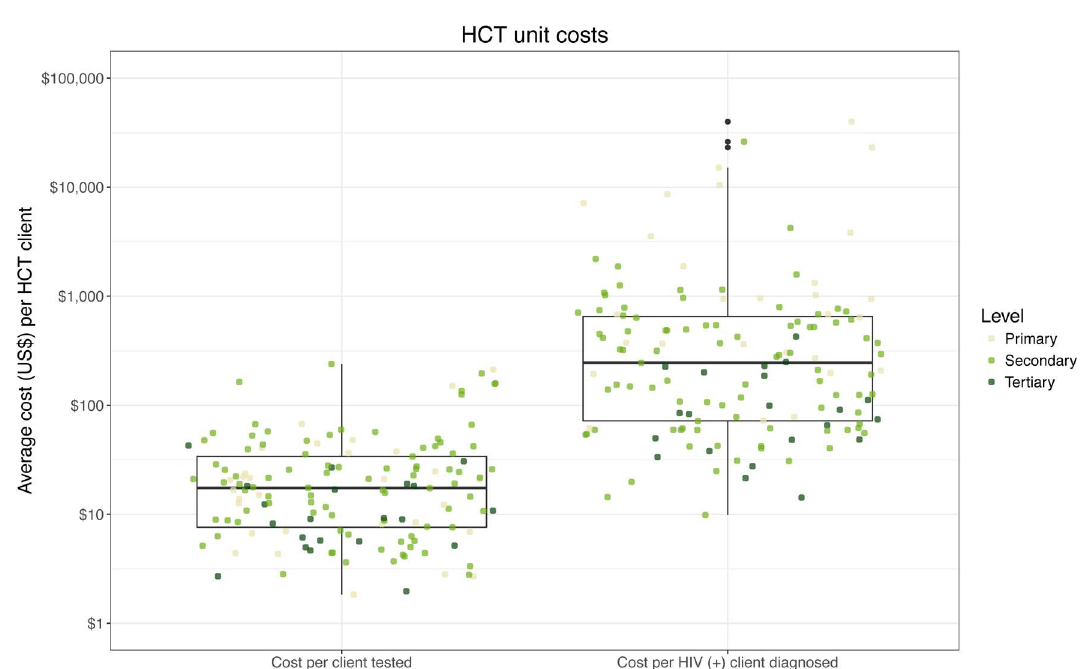
Fig 3. HCT average costs by cascade stage and level of care. Note: Lines inside the box indicate the median of the distribution; boxes depict the inter-quartile range (IQR); whiskers extend to 1.5 times the IQR.